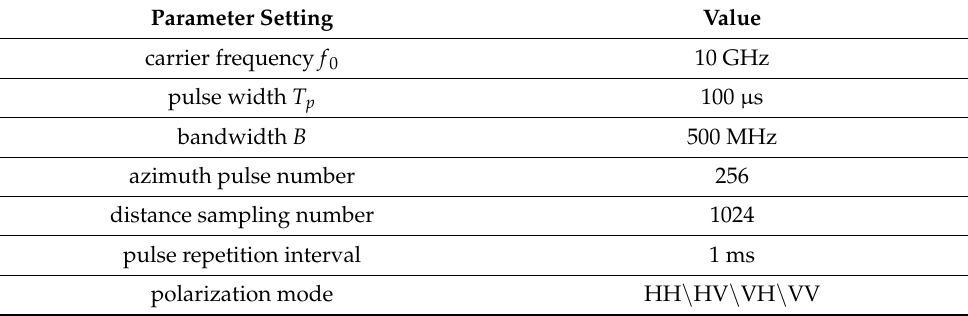
Table 1. Radar parameter setting.